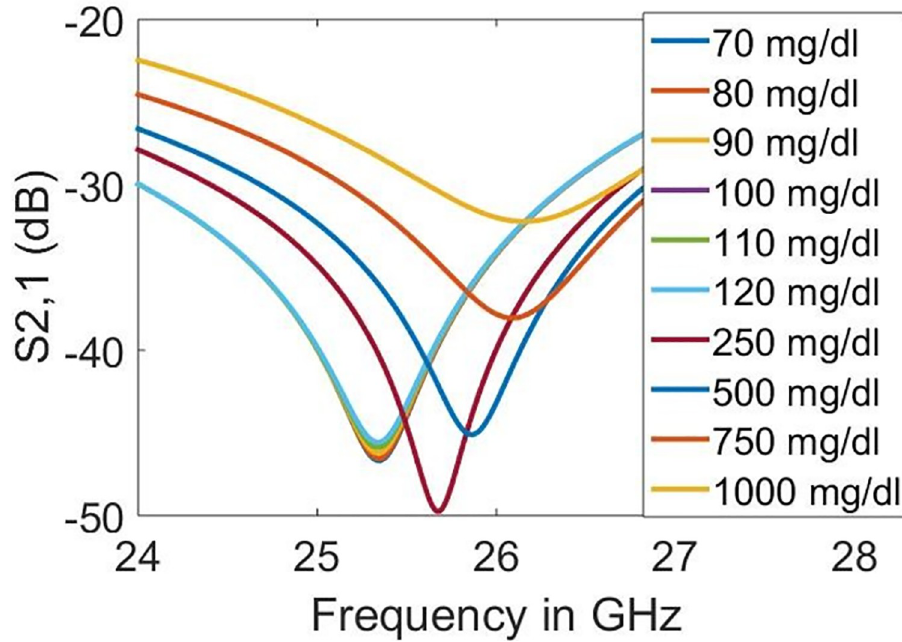
Fig 15. Transmission coefficient responses on different glucose